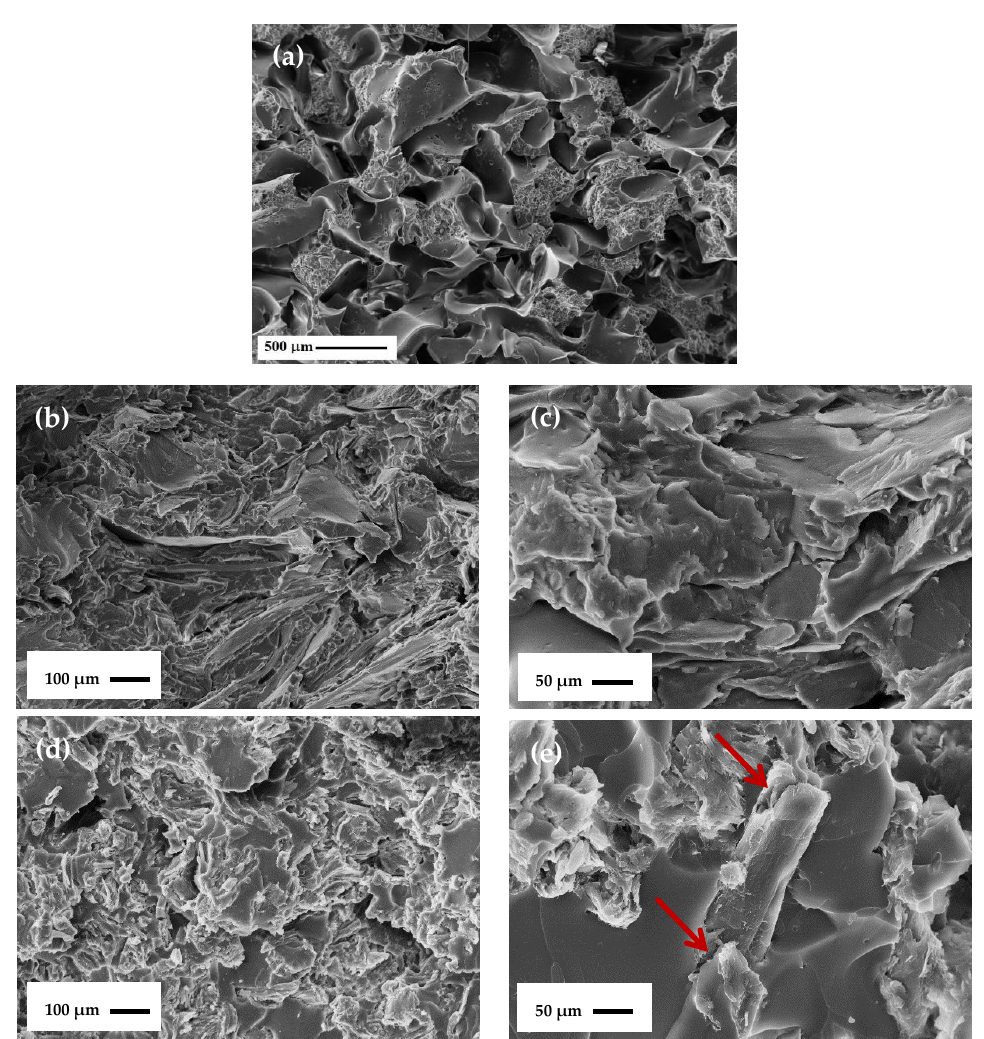
Figure 2. SEM images of the fractured surfaces for ( a ) pristine lignopolyurethane and composites reinforced with ( b and c ) CNC and ( d and e ) MCC; the arrows indicate the short MCC fibers covered by the matrix. Fibers 2020 , 8 , x